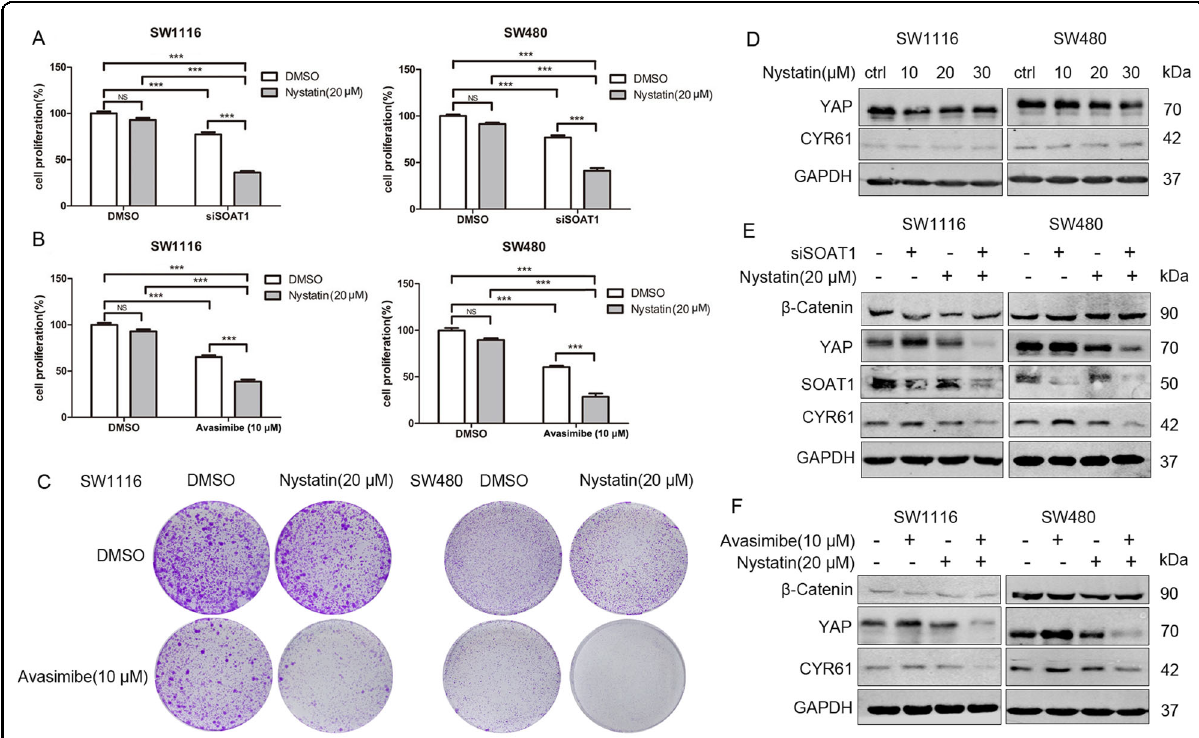
Fig. 5 Targeting SOAT1 synergizes with nystatin in suppressing the viability of colon cancer cells in vitro. A SW1116 and SW480 were treated with control siRNA or siSOAT1 in the presence or absence of nystatin (20 μ M). Cell proliferation activity was detected by CCK-8 after 72 h. B SW1116 and SW480 were treated with DMSO or avasimibe (10 μ M) in the presence or absence of nystatin (20 μ M). Cell proliferation activity was detected by CCK-8 after 72 h. C SW1116 and SW480 were incubated with DMSO or avasimibe (10 μ M) in the presence or absence of nystatin (20 μ M) for 5 d, respectively. The cell proliferation ability was detected by the colony formation assay. D SW1116 and SW480 were treated with nystatin (10 – 30 μ M) for 16 h. E SW1116 and SW480 were transfected with negative control siRNA or SOAT1 siRNA for 48 h, respectively. The cells were then incubated with DMSO or nystatin (20 μ M) for 16 h. F SW1116 and SW480 were incubated with DMSO or avasimbie (10 μ M) in the presence or absence of nystatin (20 μ M) for 16 h, respectively. The expression of proteins was detected by Western